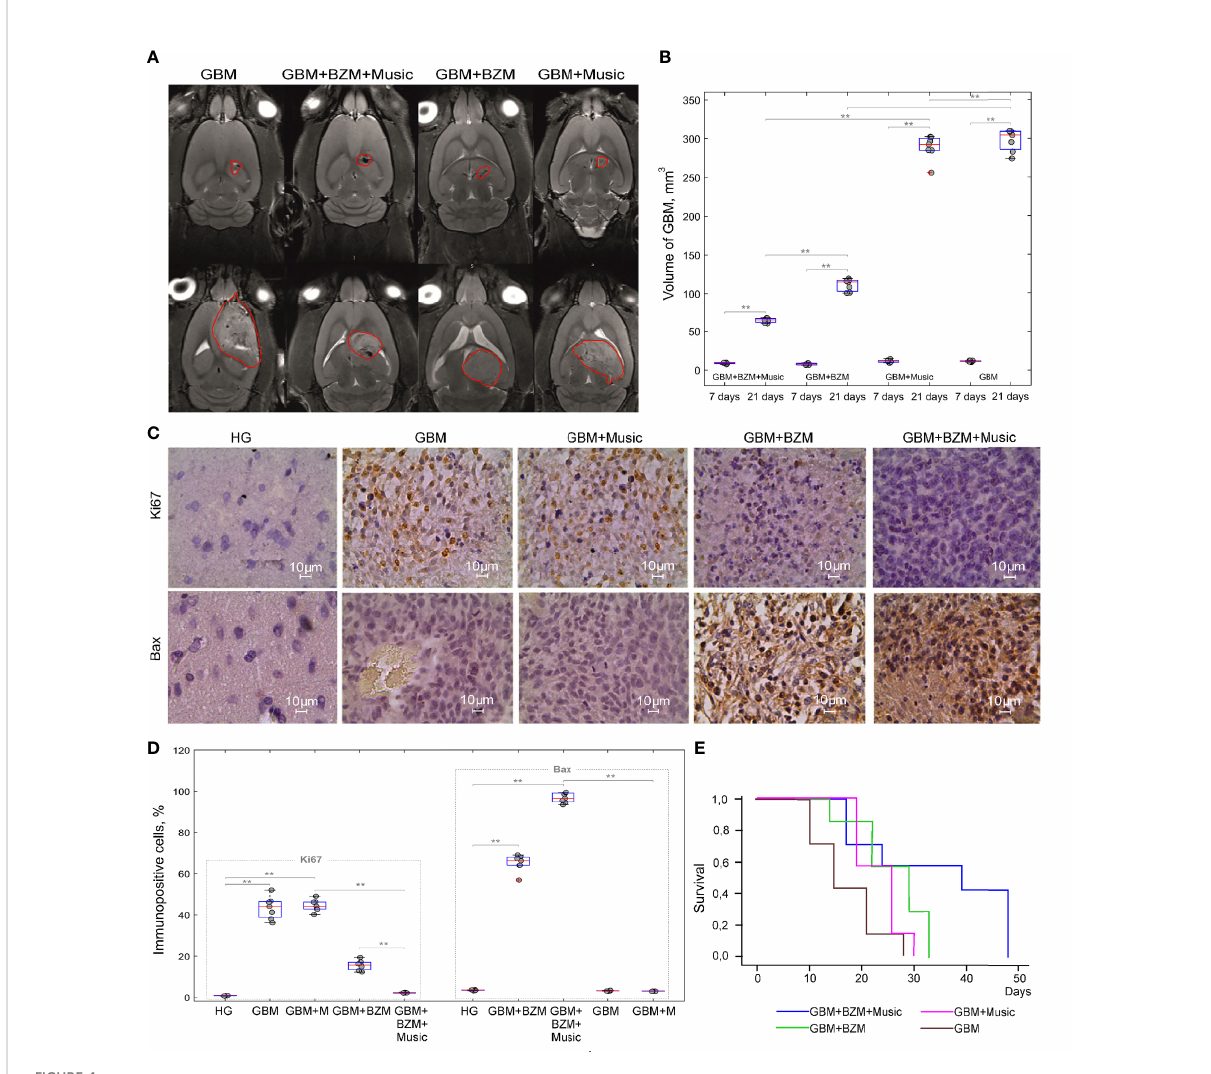
FIGURE 4 The effects of BZM on the GBM growth and survival in rats with the intact and the opened BBB: (A) Representative MRI images of GBM in the GBM, GBM+Music, GBM+BZM, and GBM+BZM+Music groups; (B) The MRI analysis of the GBM volume in the GBM, GBM+Music, GBM+BZM, and GBM+BZM+Music groups, the Mann – Whitney – Wilcoxon test, **p<0.01, n=7 in each group; (C) The ICH assay of expression of Ki67 (marker of proliferation) and Bax (marker of apoptosis) in the HG, GBM, GBM+BZM, GBM+Music, and GBM+BZM+Music groups; (D) The quantitative analysis of immunopositive cells (%) expressed Bax and Ki67 in the HG, GBM, GBM+BZM, GBM+Music, and GBM+BZM+Music groups, the Mann – Whitney – Wilcoxon test, **p<0.01, n=7 in each group; (E) Kaplan – Meier overall survival plots in the GBM, GBM+BZM, GBM+Music, and GBM+BZM+Music groups, n=7 in each group. GBM, glioblastoma; BZM, bevacizumab; HG, healthy